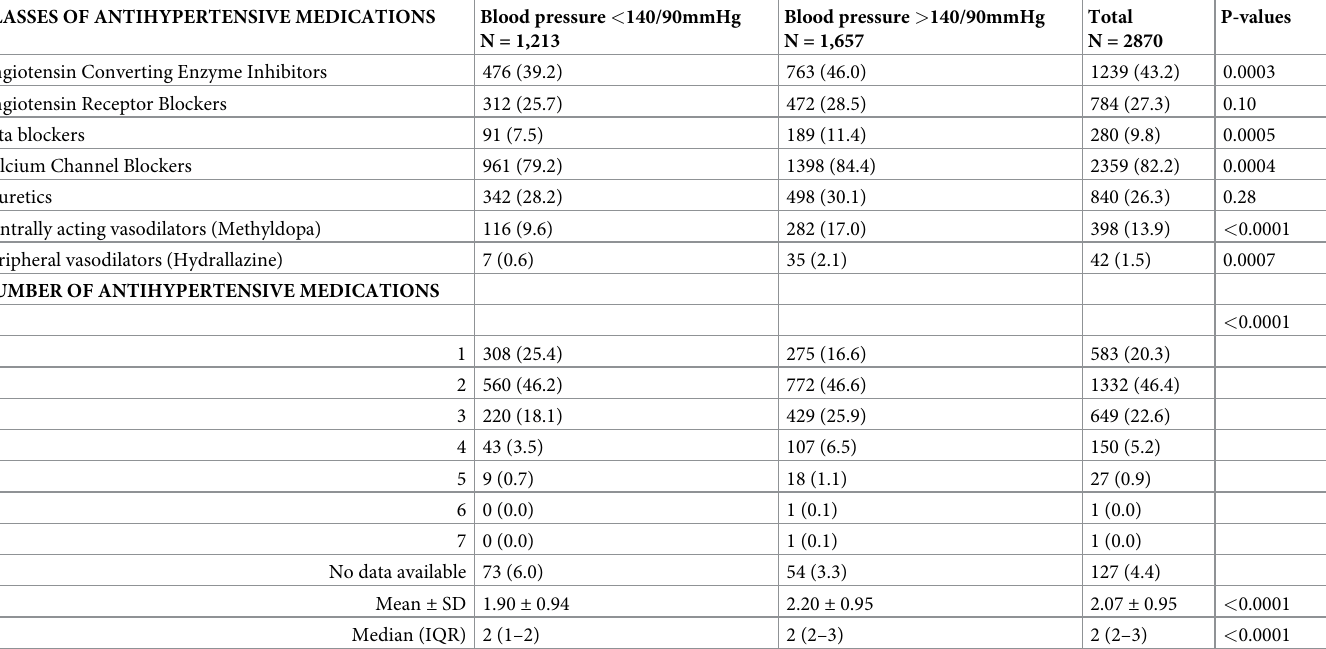
Table 5. Antihypertensive drug classes and combinations according to BP control status. CLASSES OF ANTIHYPERTENSIVE